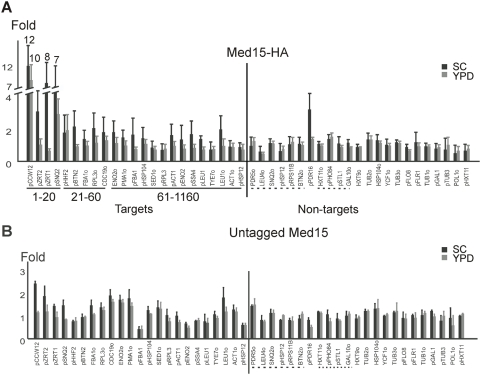
Mediator association at putative target and non-target regions in SC and YPD medium.(A) Association of Med15-(HA)3 was determined at the indicated genomic regions as described previously [10]. Relative occupancy values were calculated by determining the apparent immunoprecipitation efficiency (ratio of immunoprecipitated to input DNA) and normalized to the average value of 10 non-target regions (underlined with dashes), which was defined as 1 and served as the internal control. All values represent the mean of at least three independent experiments and the standard deviation is indicated. The indicated ranks of genomic regions are taken from Andrau et al. (2006) by sorting by Mediator.BR descending of the 1241 targets (gene names: p, promoter regions; o, ORF regions) and the rest of non-targets separately. (B) Control experiment with an isogenic yeast strain expressing untagged Med15. Relative occupancy values were normalized to the average of 10 non-target regions.